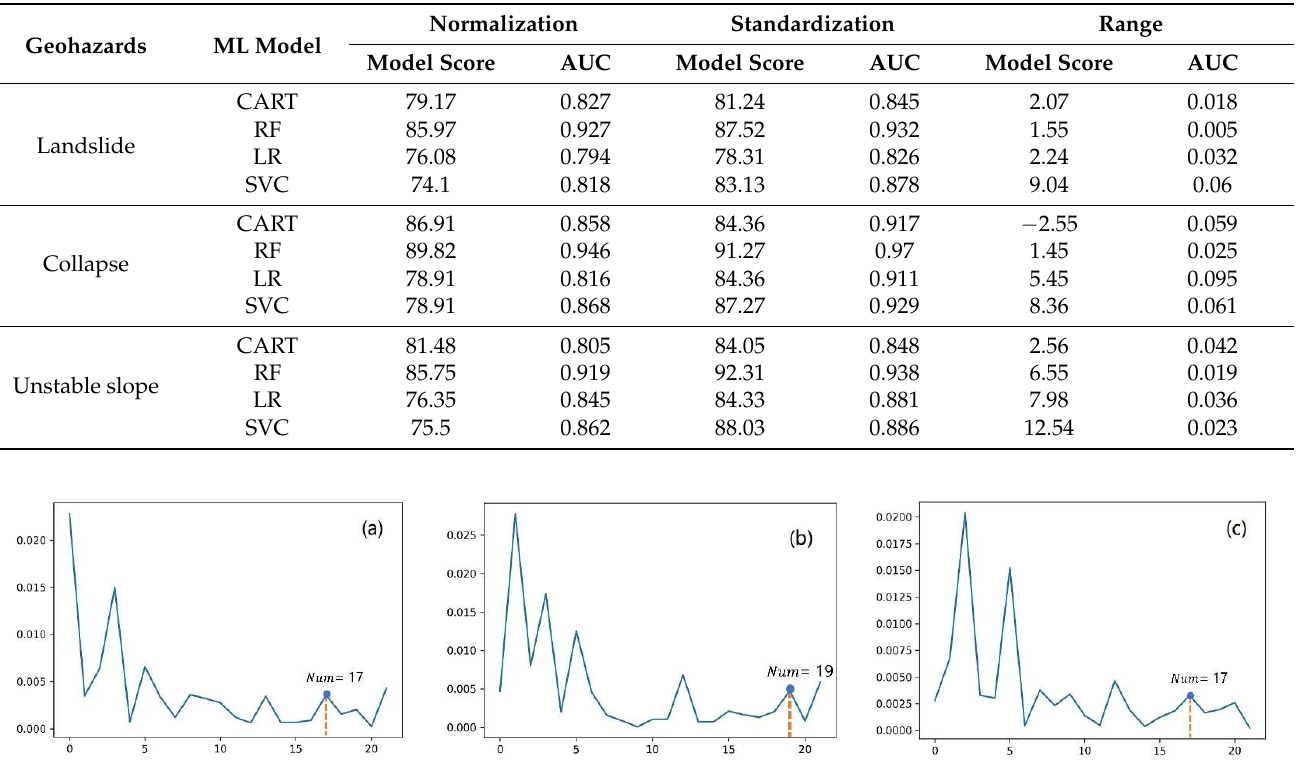
Table 5. Results of model scores and AUCs using normalization and standardization as feature enhancement method; standardization made for a better performance in model scores in all cases except for CART.